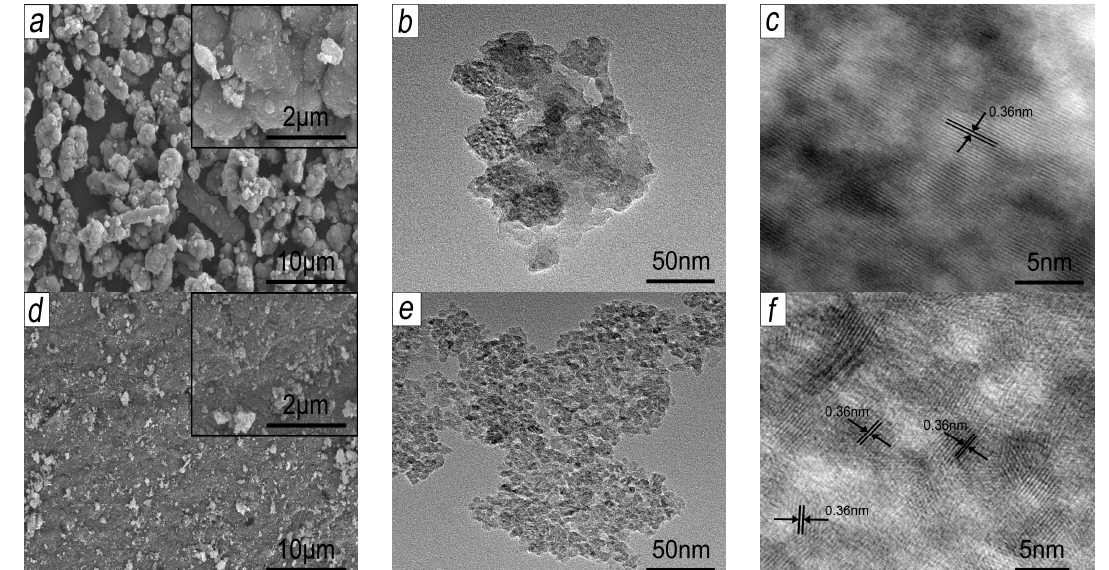
Figure 2. SEM, TEM and HRTEM micrographs of BFS ‐ TiO 2 samples made at different pH values of hydrolysis: ( a ‐ c ) NA; and ( d ‐ f ) pH 1.